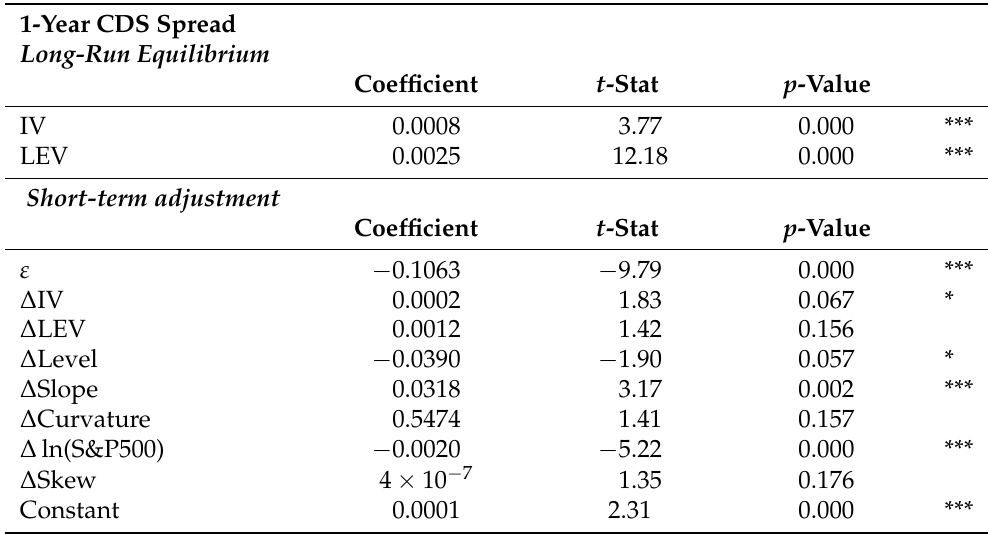
Table 11. ECM for 1-year CDS spreads using the average implied volatility of put options instead of σ S . Similar results are obtained; however, the implied volatility is significant only at the 10% significance level in the short-term adjustment equation. Additionally, ∆ LEV, ∆ Curvature and ∆ Skew have become insignificant, and ∆ Level is significant at the 10% significance level only.